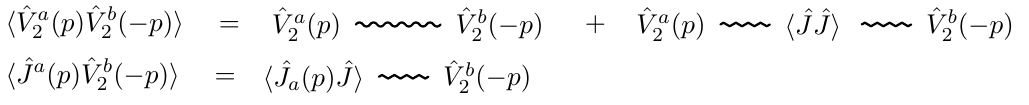
2 and the two-point